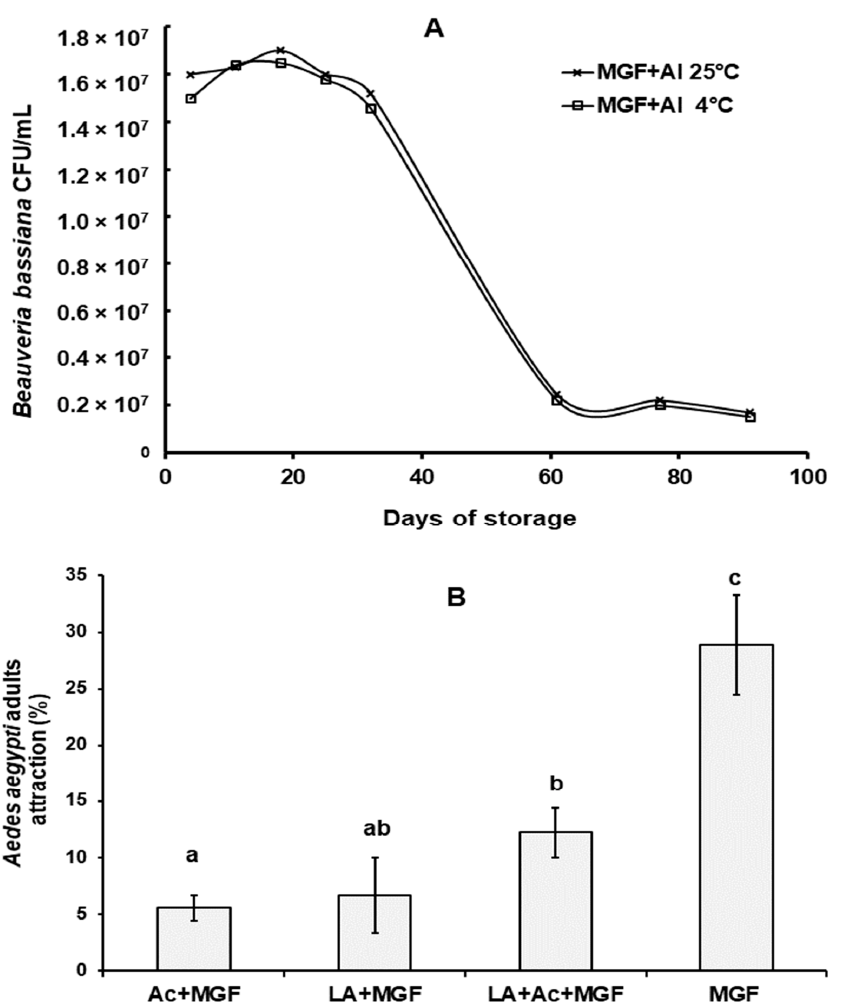
Figure 1. Beauveria bassiana BBPTG4 strain ( A ) conidia viability in microgranular formulation (MGF). Conidia viability was determined in MGF at time zero (4 d) (1.5 × 10 7 conidia/mL as active ingredient (AI) with MGF) and up to 91 d storage at 25 °C ± 2 °C or 4 °C ± 1 °C, as explained in the text. ( B ) Percentages of Ae. aegypti adults attracted to different treatments. Ae. aegypti adults were exposed to MGF without additive, MGF + acetone (added at 1% ( w / v ) of MGF), MGF + 100 µL/g of lactic acid at 85%, and MGF + 100 µL/g of lactic acid at 85% + 1% acetone/g of MGF and attraction percentages determined, as explained in the text. Data represent mean + SEM of triplicate determinations from three independent experiments. Same letter on each column indicates that treatments are not significantly different (HSD Tukey test; p ˂ 0.05).